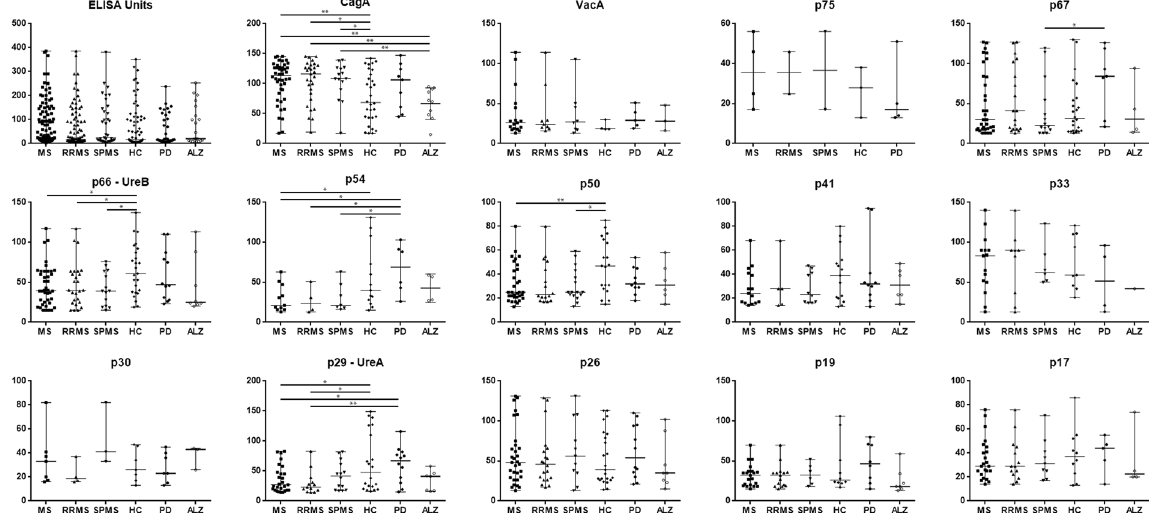
Figure 4. Scatter plots depicting antibody levels against individual Hp antigens in patients with multiple sclerosis (total, RRMS and SPMS), healthy controls (HC), patients with Parkinson’s disease (PD) and patients with Alzheimer’s disease (ALZ). * p < 0.05, ** p < 0.01. Abbreviations: CagA, protein from cytotoxin-associated gene A; UreA, urease A; UreB, urease B; VacA, vacuolating cytotoxin A.